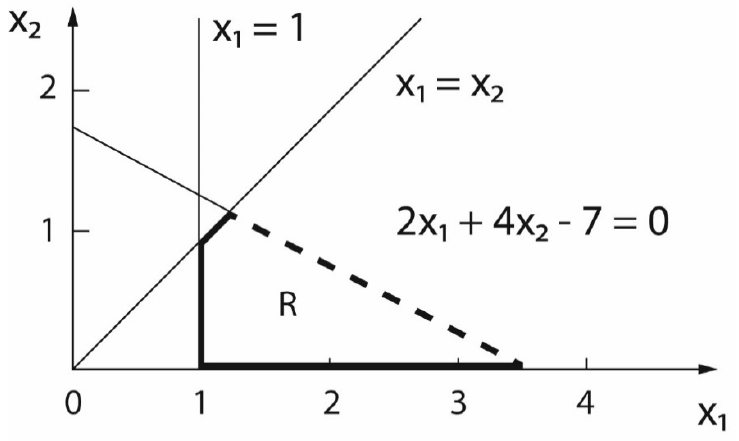
Figure 1. Zone R in (x 1 ,x 2 )-plane where a X = 1.